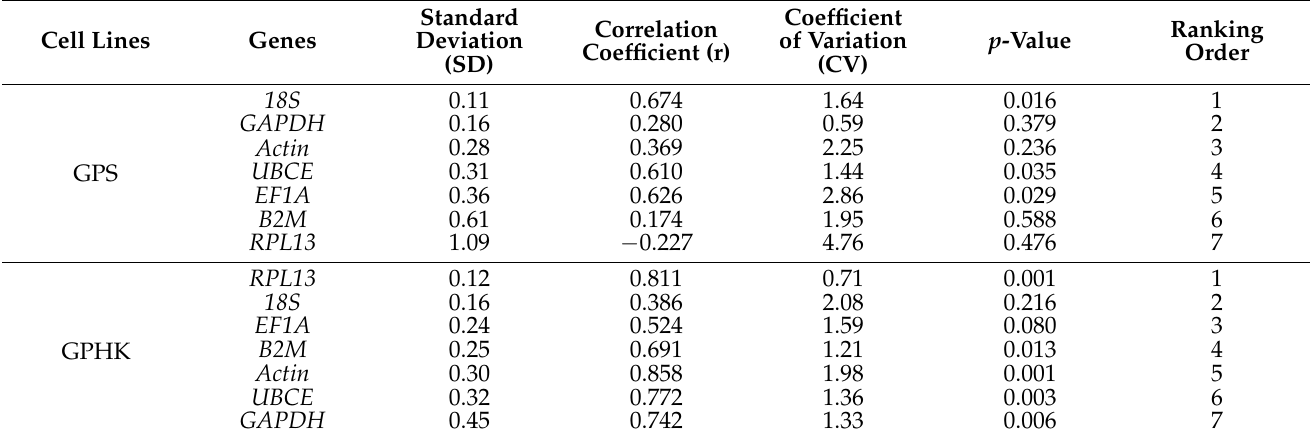
Table 5. The expression stability of housekeeping gene candidates in GPS and GPHK cells under normal conditions assessed by BestKeeper analysis.